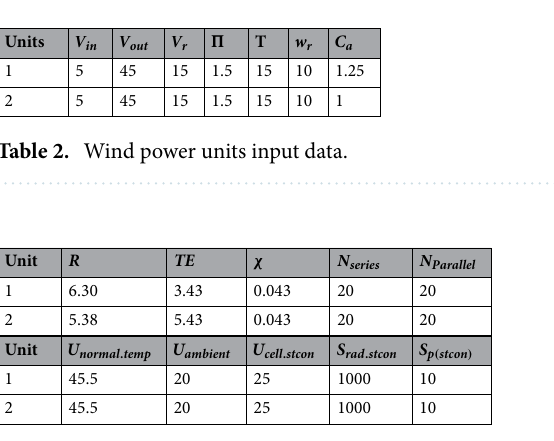
Table 3. Solar power input